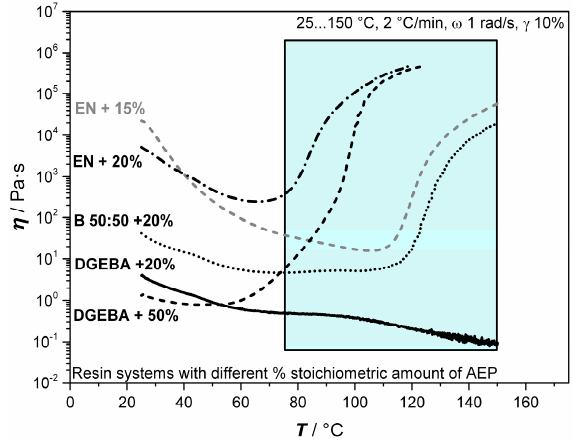
Figure 6. Rheological investigations of DGEBA, EN, and its 50:50 blend with a stoichiometric amount of AEP (presented in % amount relative to 100% stoichiometric). The grey region illustrates the range, where B-AEP decomposition is releasing further AEP in the foaming process, whereas a different viscosity behavior is expected.